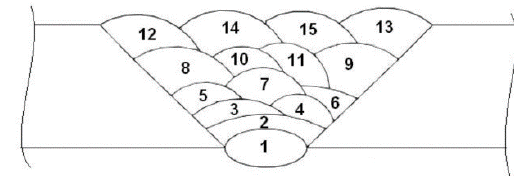
Figure 1. Sequence of weld passes.